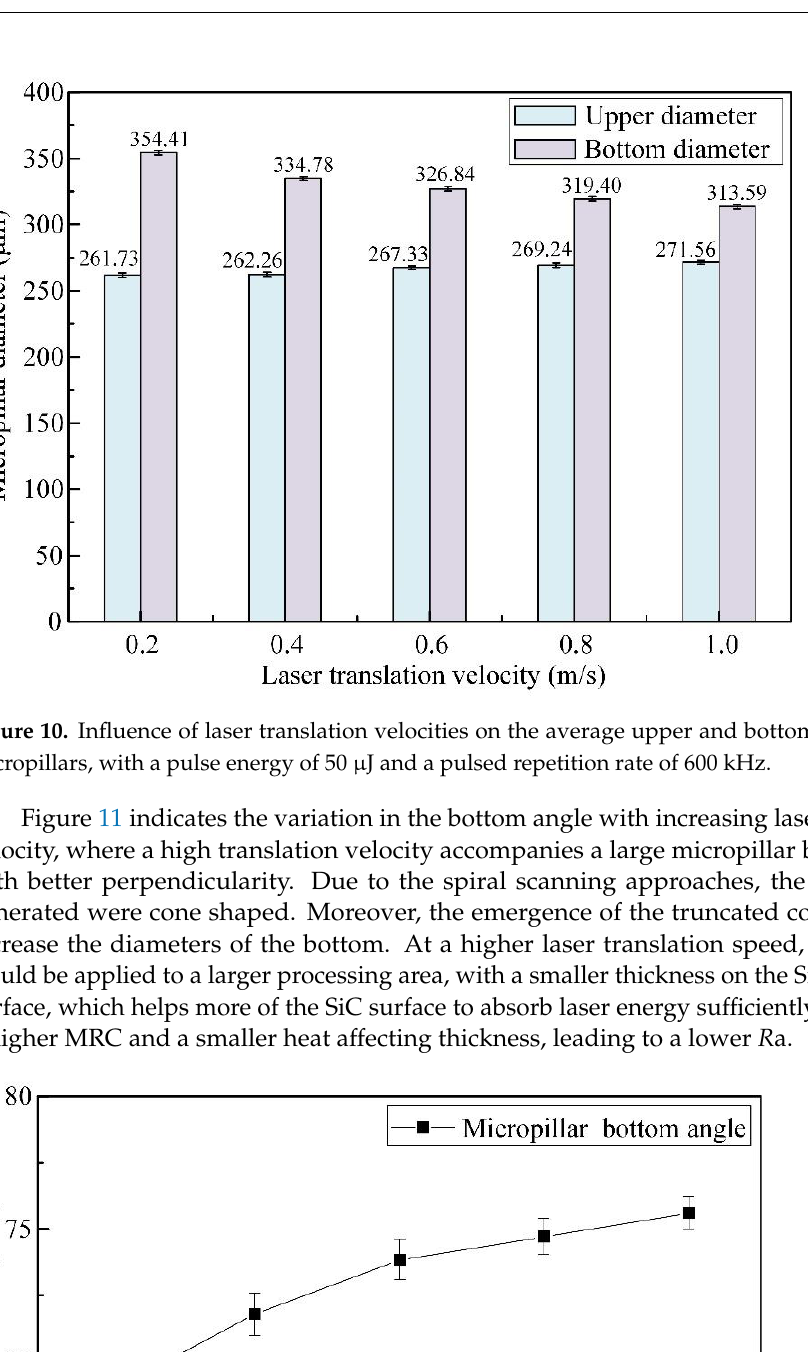
a higher MRC and a smaller heat affecting thickness, leading to a lower R a.